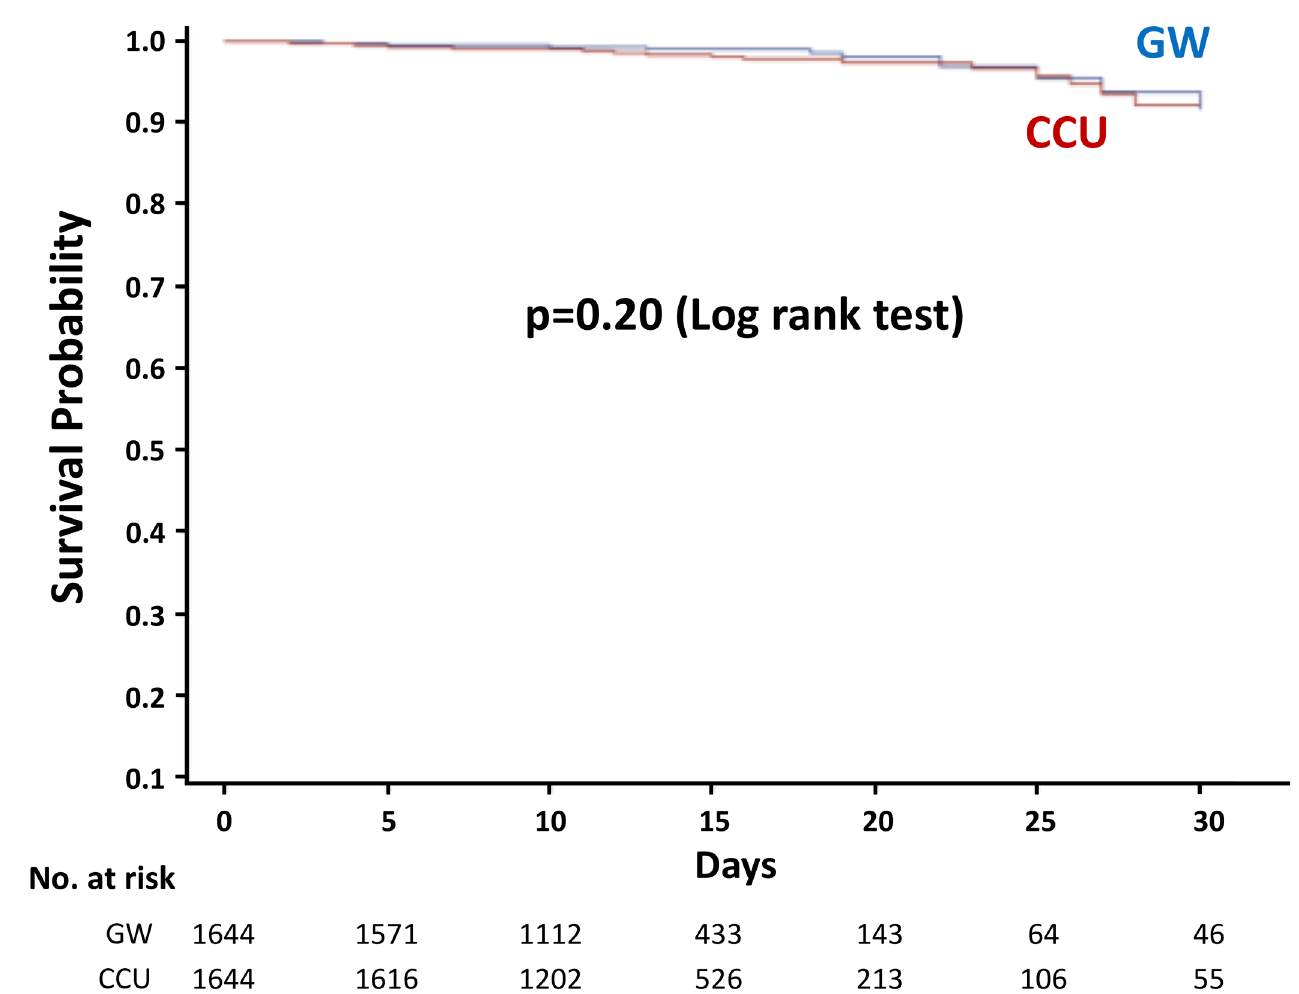
Fig 2. Kaplan–Meier curves for the probability of survival after propensity score matching. CCU, coronary care unit; GW, general ward.